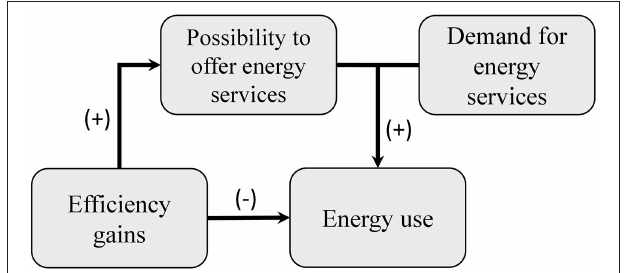
FIGURE 4 | Efficiency gains create room for more